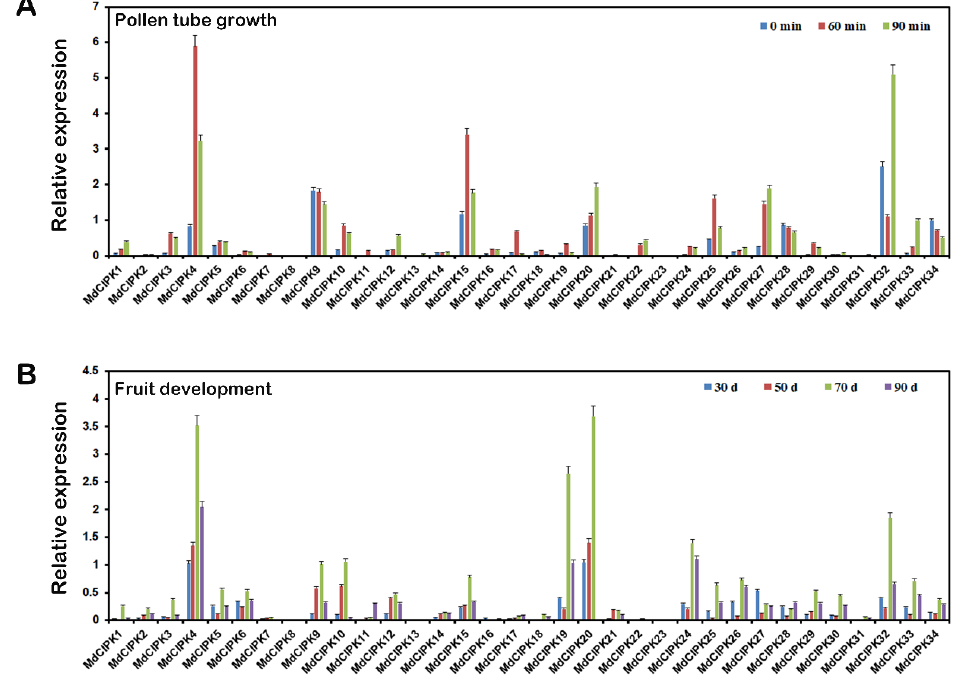
Figure 6. The image summarizes the expression profiles of the 34 MdCIPK genes at four stages of pollen tube growth and fruit development. The apple pollen tube at 0, 60 and 90 h after pollination ( A ). The apple fruit harvested at 30, 50, 70 and 90 days after bloom ( B ). Three replicates (1 – 3) were performed for each stage.